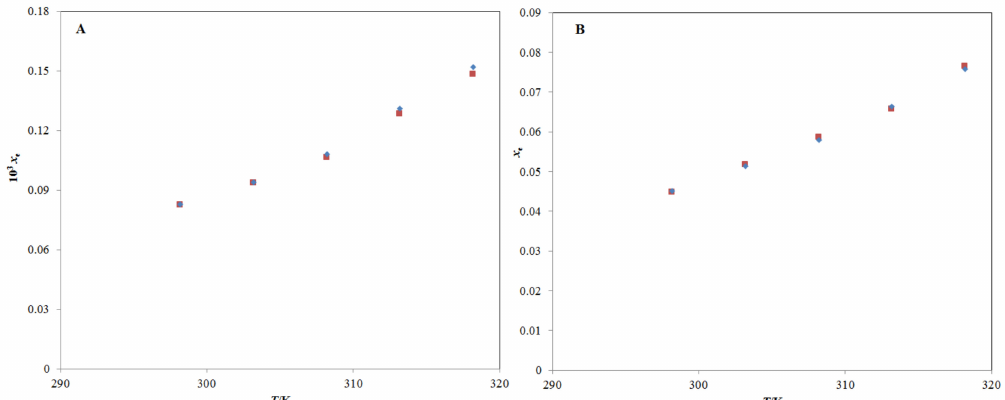
Figure 2. Graphical comparison of TQ solubility in ( A ) neat H 2 O and ( B ) neat IPA with literature values at 298.2–318.2 K; the symbol represents the TQ experimental solubility in ( A ) neat H 2 O and ( B ) neat IPA, and the symbol represents the TQ literature solubility values in ( A ) neat H 2 O and ( B ) neat IPA taken from reference